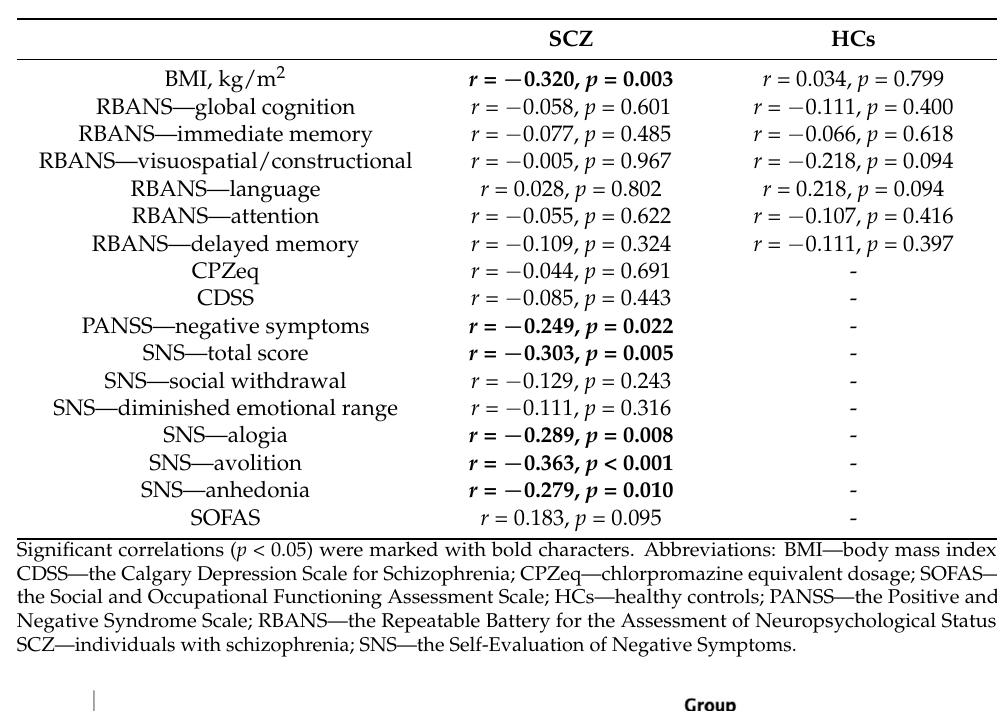
Table 2. Bivariate correlations of the aMED score.